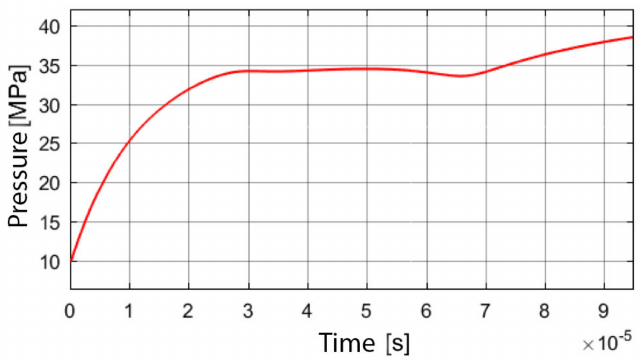
Figure 24. Sample result of the simulation using the Simulink discreet